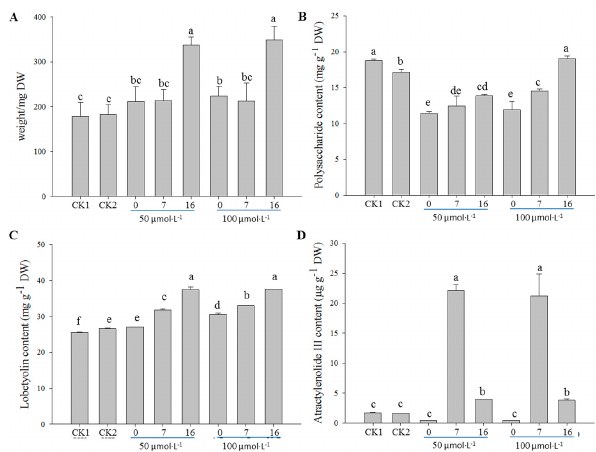
Figure 1. Effect of different time to start treatment (at the 0, 7th, and 16th day of subculture) on biomass ( A ), contents of polysaccharide ( B ), lobetyolin ( C ), and atractylenolide III ( D ) in the adventitious roots of C. pilosula treated with 50 and 100 µ mol · L − 1 methyl jasmonate (MeJA), respectively. The samples were collected at the 24th day of subculture and then analyzed. CK1, blank control; CK2, solvent control. Statistically significant differences between the means were determined using Fisher’s LSD test p < 0.05) and indicated with different lowercase letters.